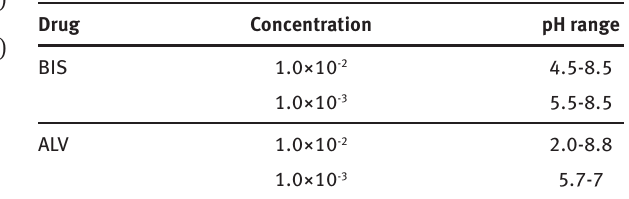
Table 2: The pH range for two different concentrations of both drugs